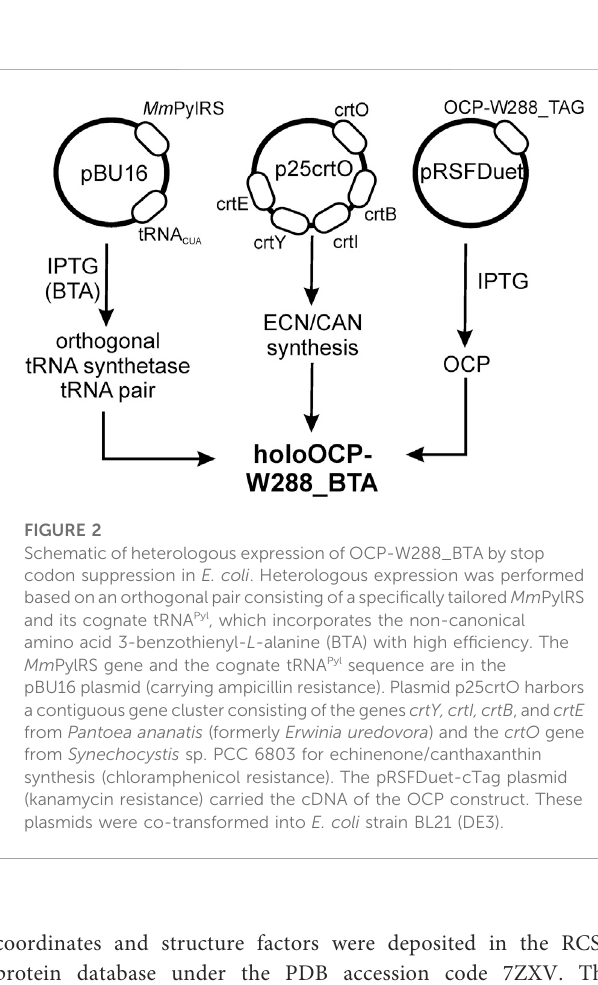
intensely stained protein solution (blue spectrum in Figure 3A) showing characteristic features of dark-adapted OCP with a small amount of a red-shifted species, which shows up as a shoulder at 570 nm (Sluchanko et al., 2017a). After an additional puri fi cation step with preparative size-exclusion chromatography (SEC), an orange and a pink protein species could be separated based on their different elution pro fi les (Figure 3B) (Sluchanko et al., 2017b). While the pink species [OCP-W288_BTA(P)] eluted earlier, the orange fraction [OCP-W288_BTA(O)] corresponded to the retention time of an OCP monomer. Figure 3A shows the representative spectra of a protein preparation that contained approximately 35% pink and 65% orange species. The puri fi ed proteins of the orange OCP-W288_BTA(O) variant and